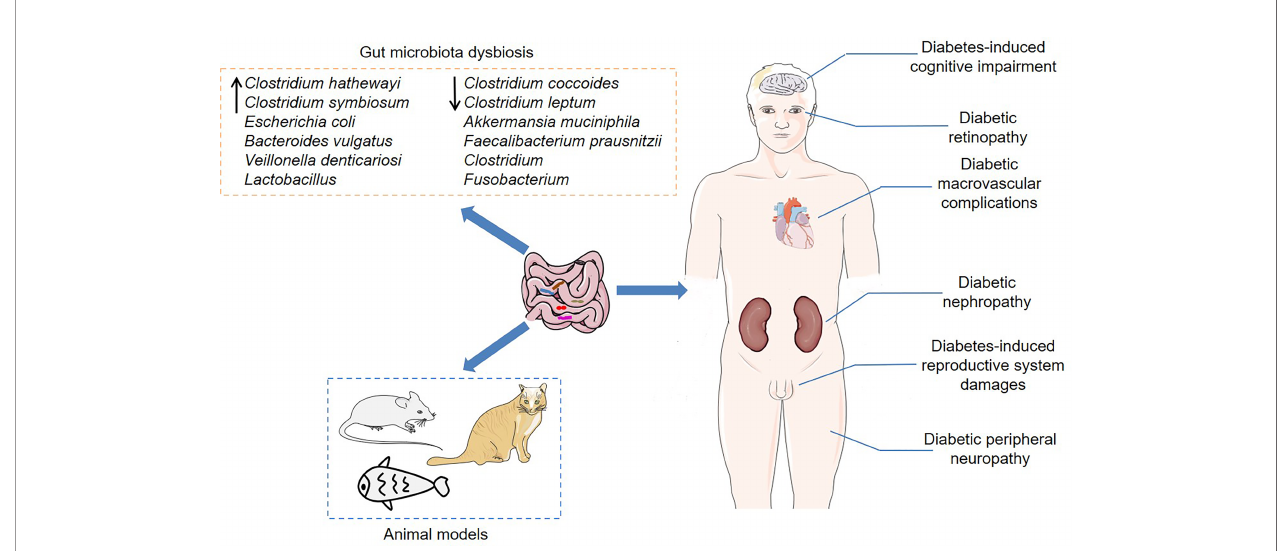
FIGURE 1 | The association between the gut microbiota and T2DM. Dysbiosis of the gut microbiota has been demonstrated not only in T2DM populations, but also in certain animal models, including mice, cats and zebra fi sh. Furthermore, the gut microbiota is closely associated with various diabetic complications, such as diabetic nephropathy, diabetes-induced cognitive impairment, diabetic retinopathy, and diabetic peripheral